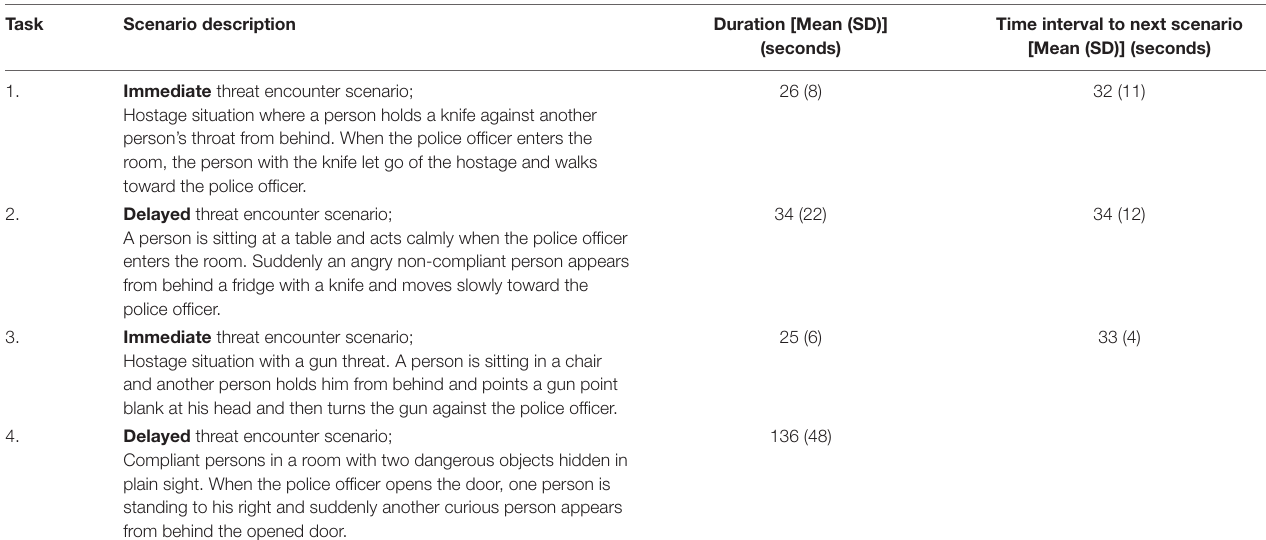
TABLE 1 | Scenario description, duration, and rest in between performing the